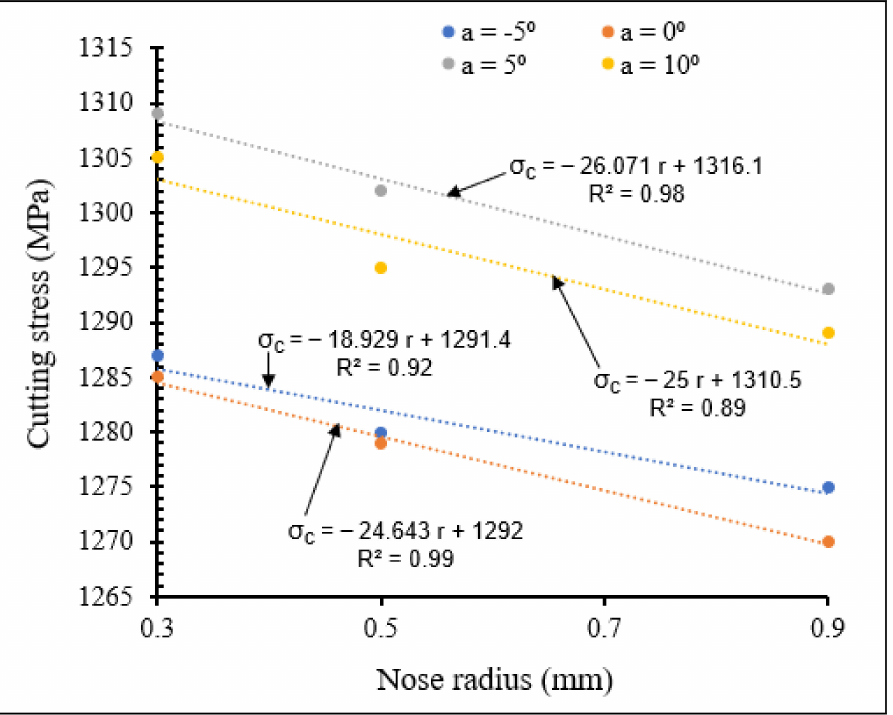
Figure 23. Variation of cutting stress with large tool nose radius for different rake angles at V = 104 m/min, f = 0.1